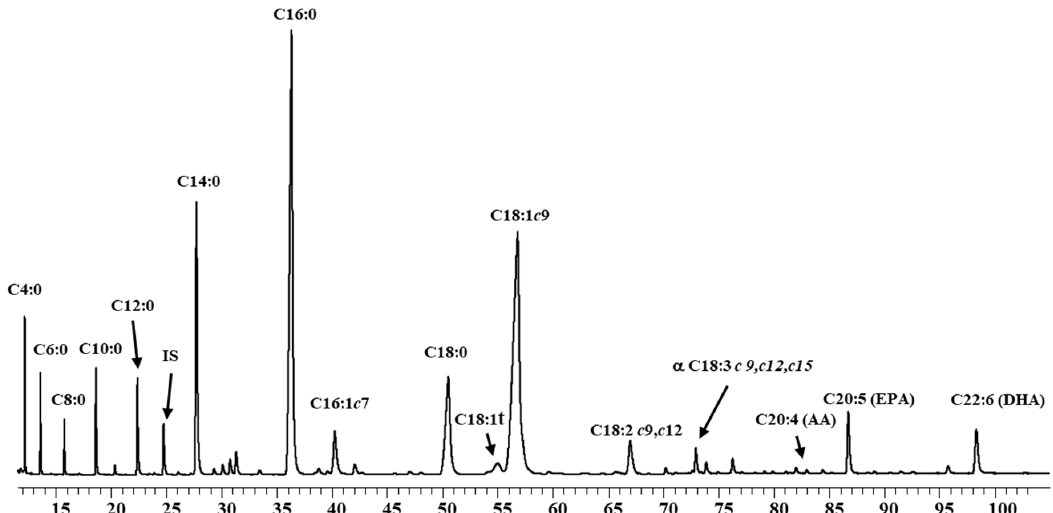
Figure 2. Fatty acid profile of PUFA UHT-enriched milk (Mw2) by gas chromatographic. c: cis ; t: trans ; AA: arachidonic acid; EPA: eicosapentanoic fatty acid; DHA: docosahexanoic fatty acid; IS: Internal Standard.